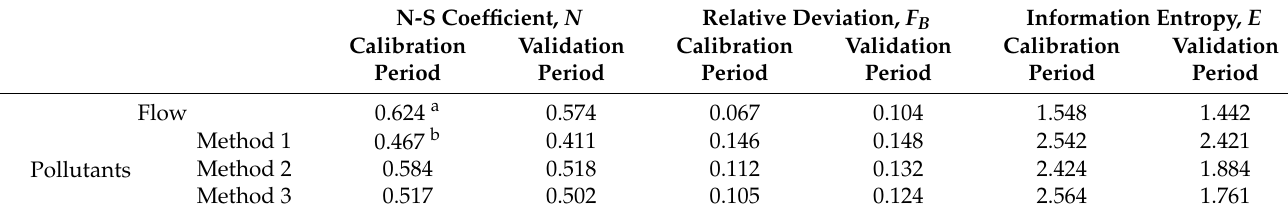
Table 3. Indexes used to evaluate the model performance.